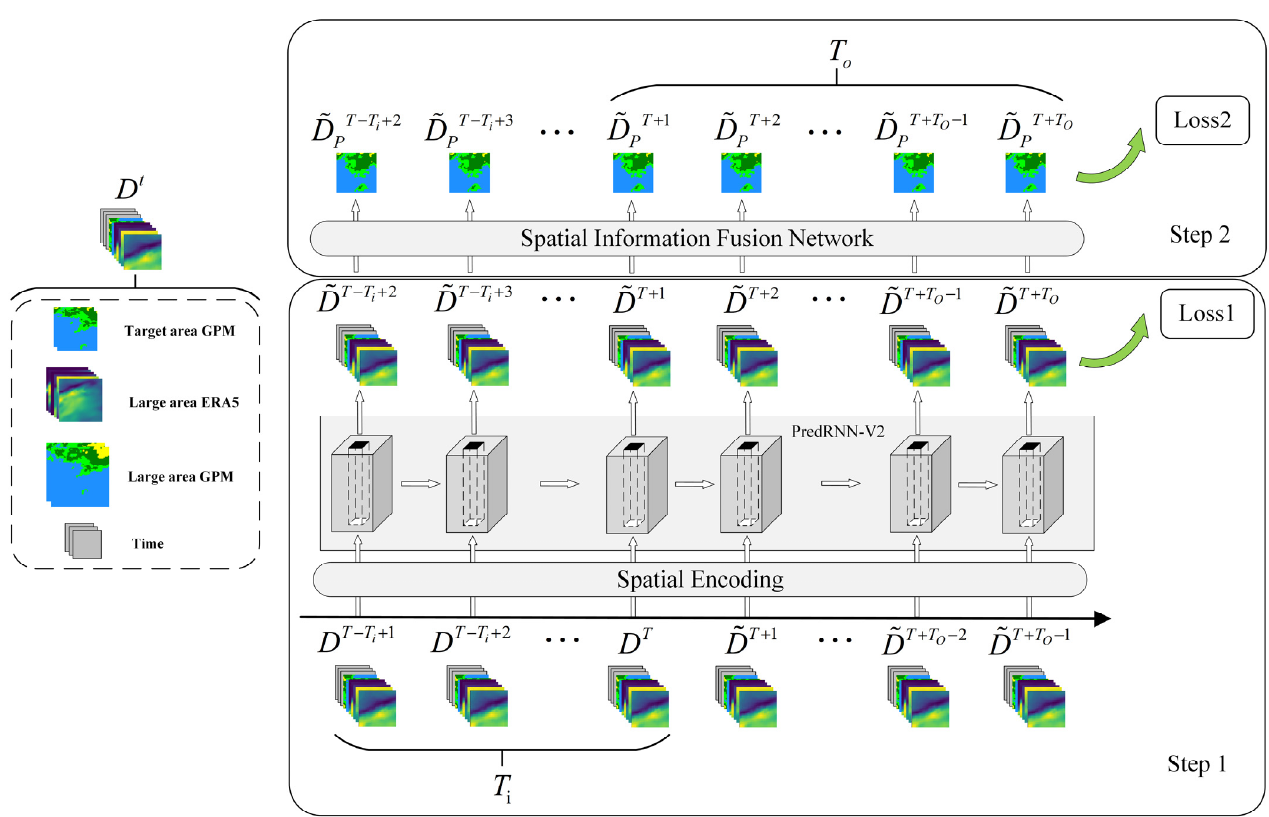
Figure 2. The Pred-SF model is divided into two steps. The first step is the spatial encoding structure and PredRNN-V2 network (Pred), which input multiple meteorological modal data D t including precipitation and output multiple meteorological modal data predicted value (cid:101) D t + 1 . The second step is the spatial information fusion network (SF), which fuses the spatial features of the predicted value (cid:101) D t + 1 and outputs the predicted precipitation value (cid:101) D Pt + 1 in the target region. To make the Pred-SF run step by step, we calculated two losses for the front and back parts, so that the model could optimize the parameters according to the requirements of the model in the training process.